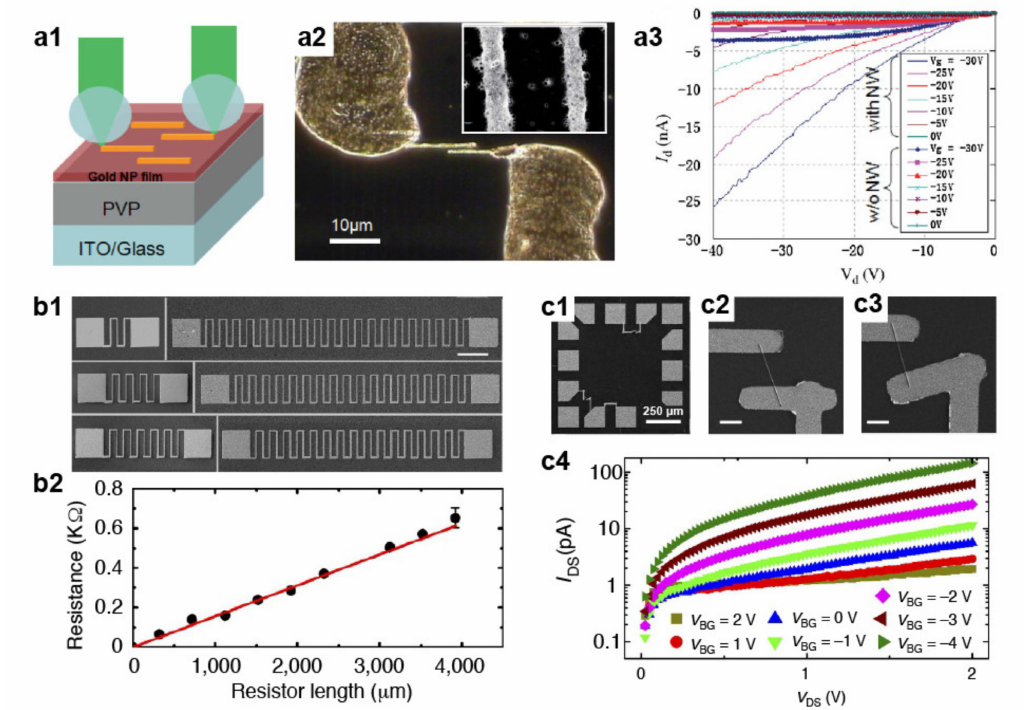
Figure 7. Nanostructures for electronics. ( a1 ) Illustration of the fabrication of nanotransistors by means of nanojet-mediated laser sintering. ( a2 ) Optical dark-field and SEM images of sintered nanowires (NWs). ( a3 ) Characteristic I–V curves of the OFET with and without NWs. Adapted with permission from [29], Copyright 2010 John Wiley & Sons, Inc. ( b1 ) Serpentine resistors patterned by exploiting an array of individually addressable hollow pyramids. Scale bar 100 µ m. ( b2 ) Plot of the resistance versus resistor length (black dots) with linear fitting (red line). ( c1 – b3 ) SEM image of electrode pads with the nanowires. The scale bar 5 µ m. ( c4 ). I–V curves for different gate voltages, highlighting the characteristic transistor behavior. Adapted with permission from [91], Copyright 2013 Springer